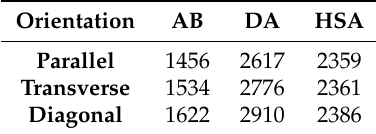
Table 4. Stress range (MPa) at (cid:101) a =0.75% in different orientations and post-treatments.